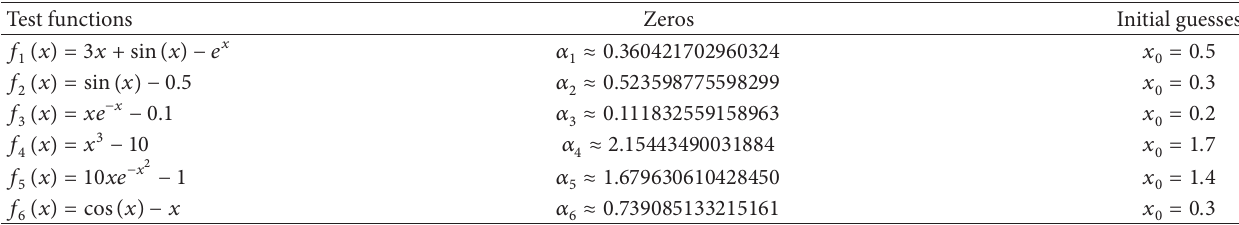
Table 1: The test functions considered in this study.